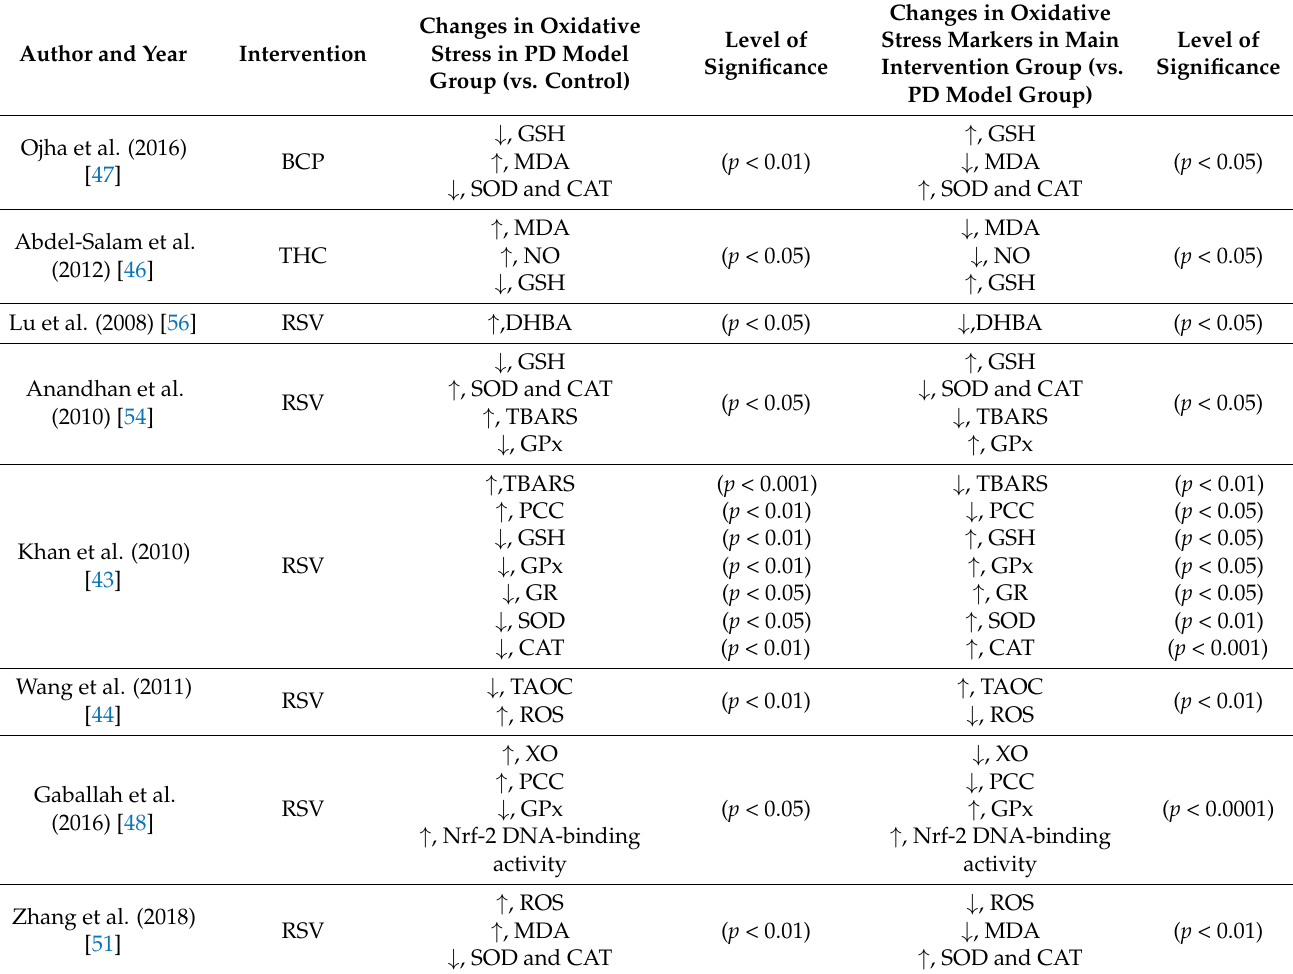
Table 5. Summary of biochemical and immunohistochemical analysis for oxidative stress markers in PD model groups and